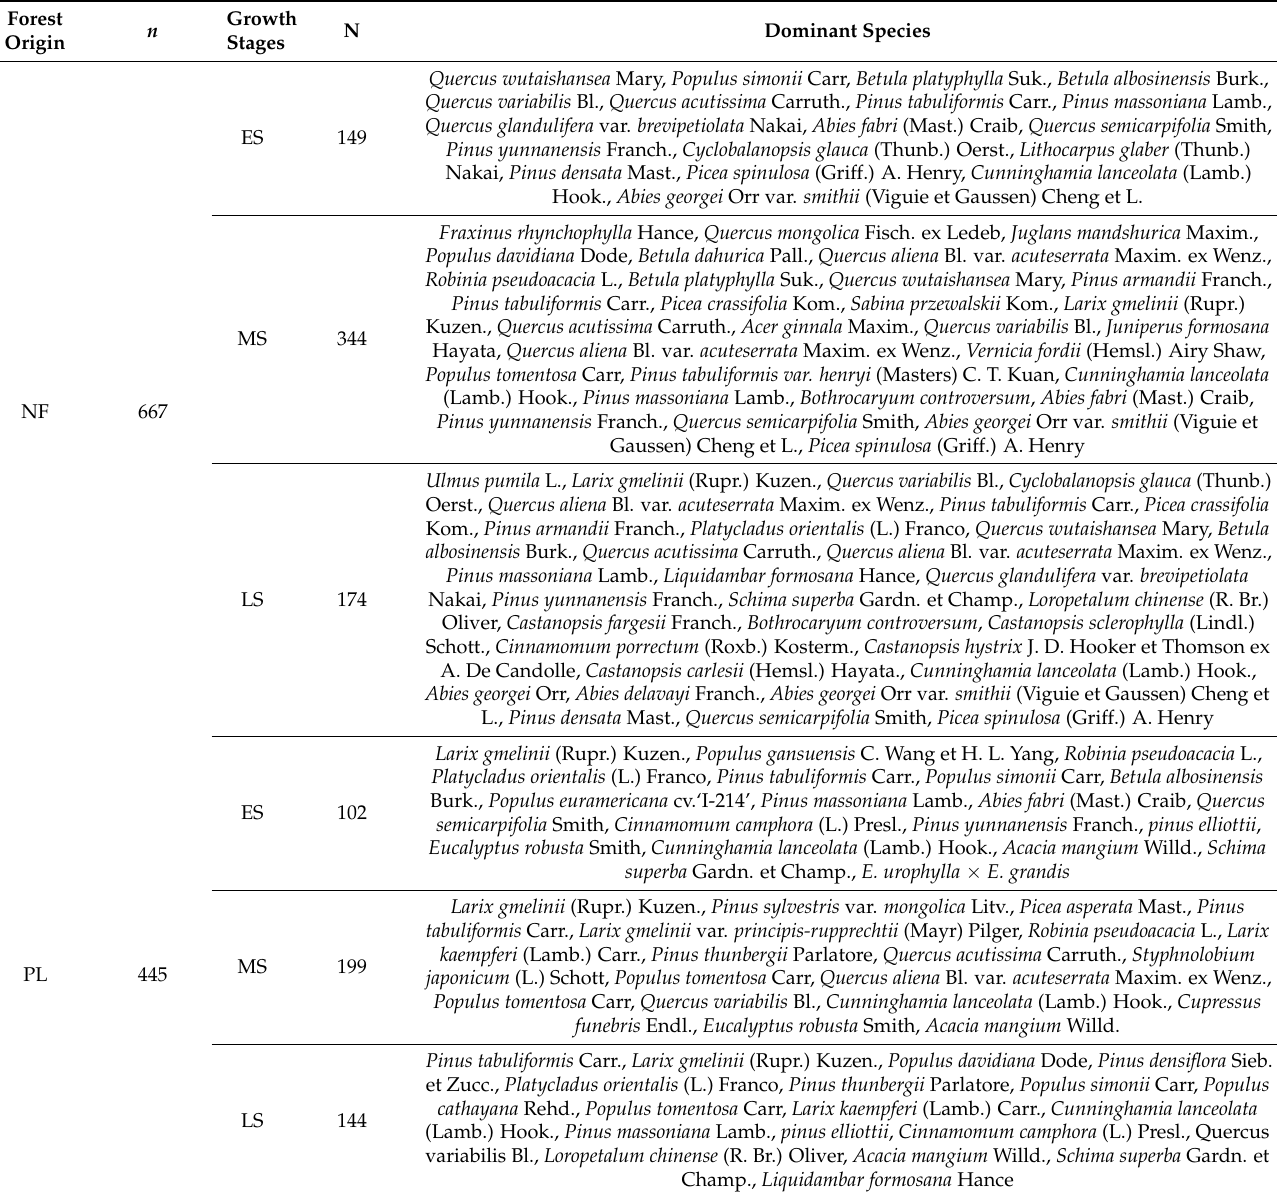
Table A1. Tree species of each growth stages in NF and